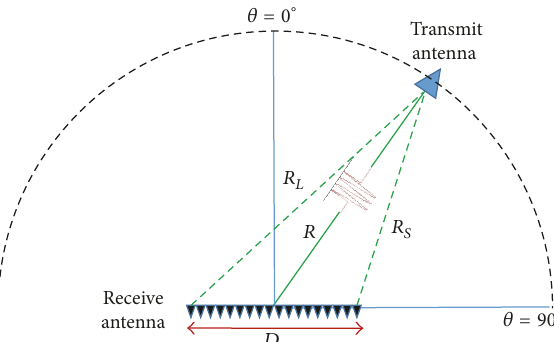
Figure 7: The transmit antenna moves in a circle about the receive